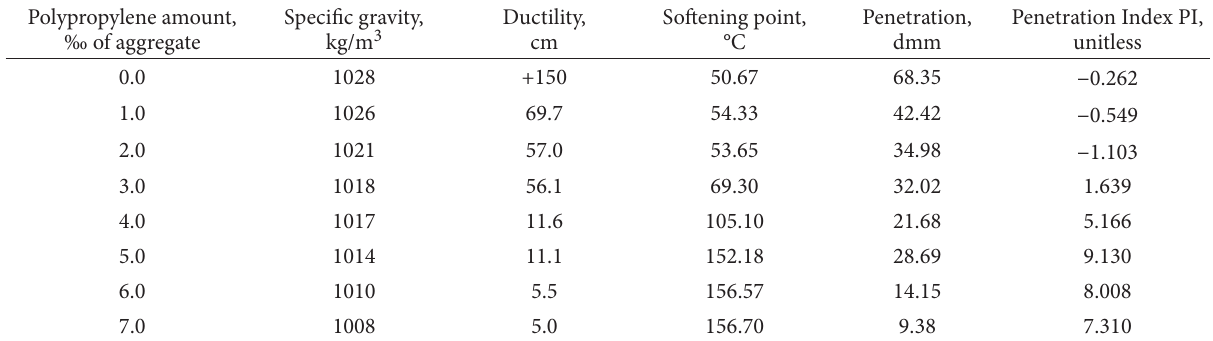
Table 5. The physical properties of control and various percentages of polypropylene modified samples Polypropylene amount, Specific gravity, Ductility, ‰ of aggregate kg/m 3